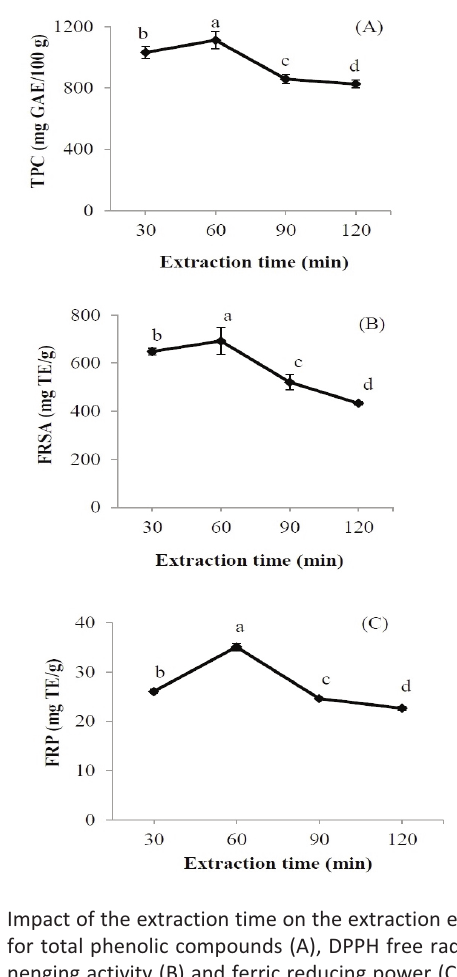
Fig. 2 ­ Impact of the extraction time on the extraction efficiency for total phenolic compounds (A), DPPH free radical sca­ nenging activity (B) and ferric reducing power (C) of egg­ plant (n= 2). Values with different letters are significantly different